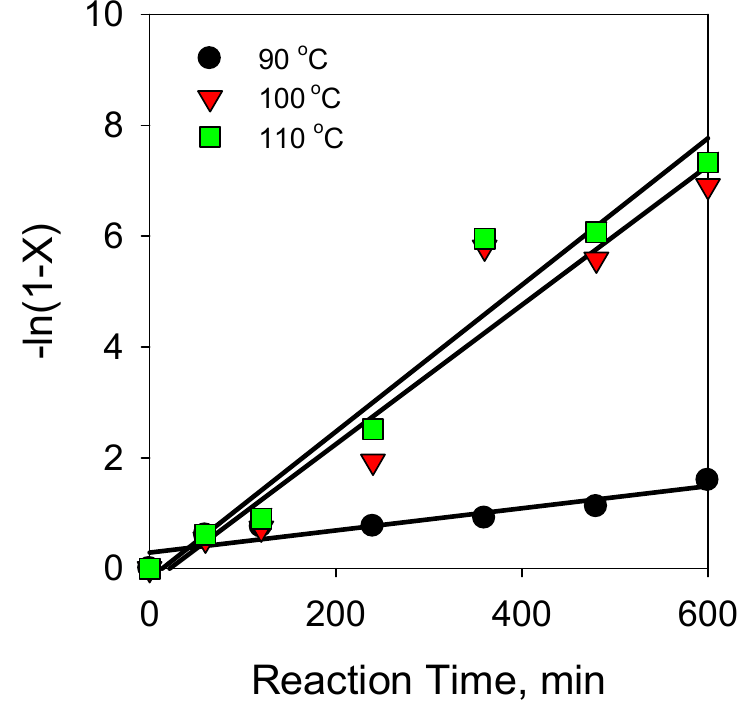
Figure 10. First-order dependence plot for hydrogenation of anthracene at 90 °C, 100 °C and 110 °C over 40 wt.% Ni/H β zeolite catalyst. Catalyst weight: 0.5 g; Reaction pressure: 6.9 MPa; H partial pressure: 2.76 MPa; volume of the reactor: 50 mL. 2